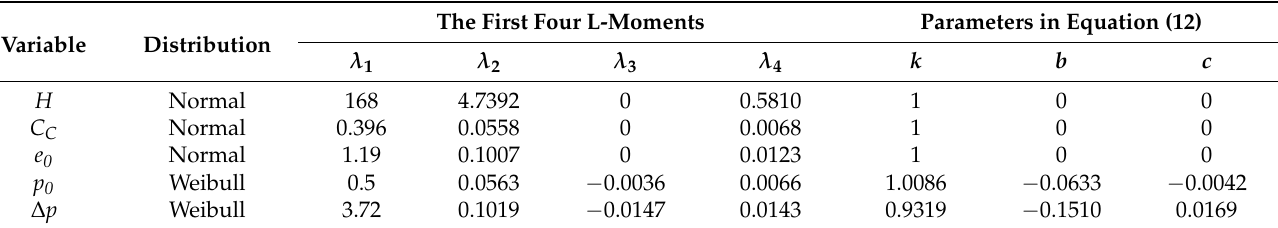
Table 3. Random variables in Example 2.